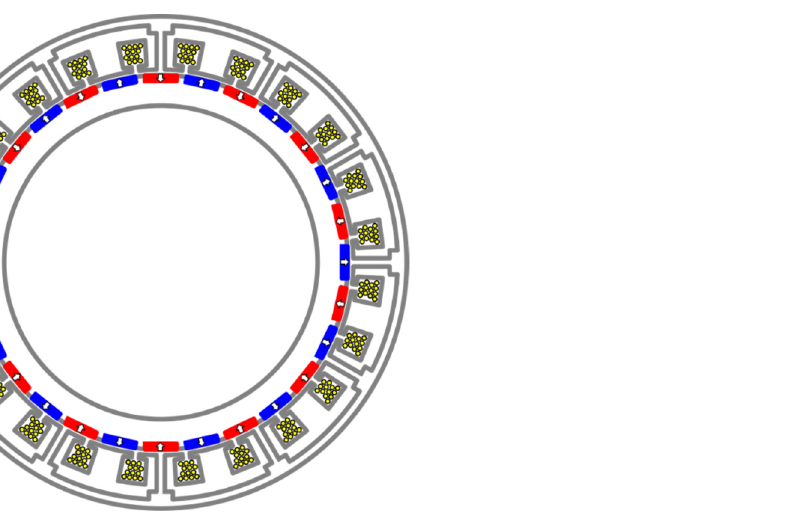
Figure 14. 24 s/28 p liquid-cooled configuration with flux barriers used as channels [93]. The flux barriers can be used on their own or as an extension of a water jacket.